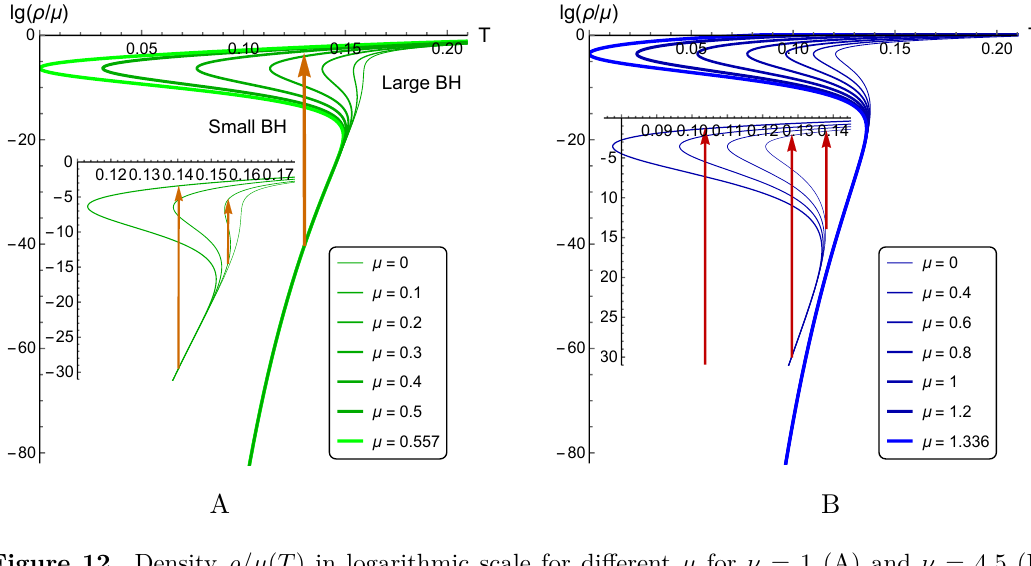
Figure 12 . Density ρ/µ ( T ) in logarithmic scale for different µ for ν = 1 (A) and ν = 4 . 5 (B); a = 4 . 046 , b = 0 . 01613 , c = 0 . 227 . Inner plots show the fragments of main plots